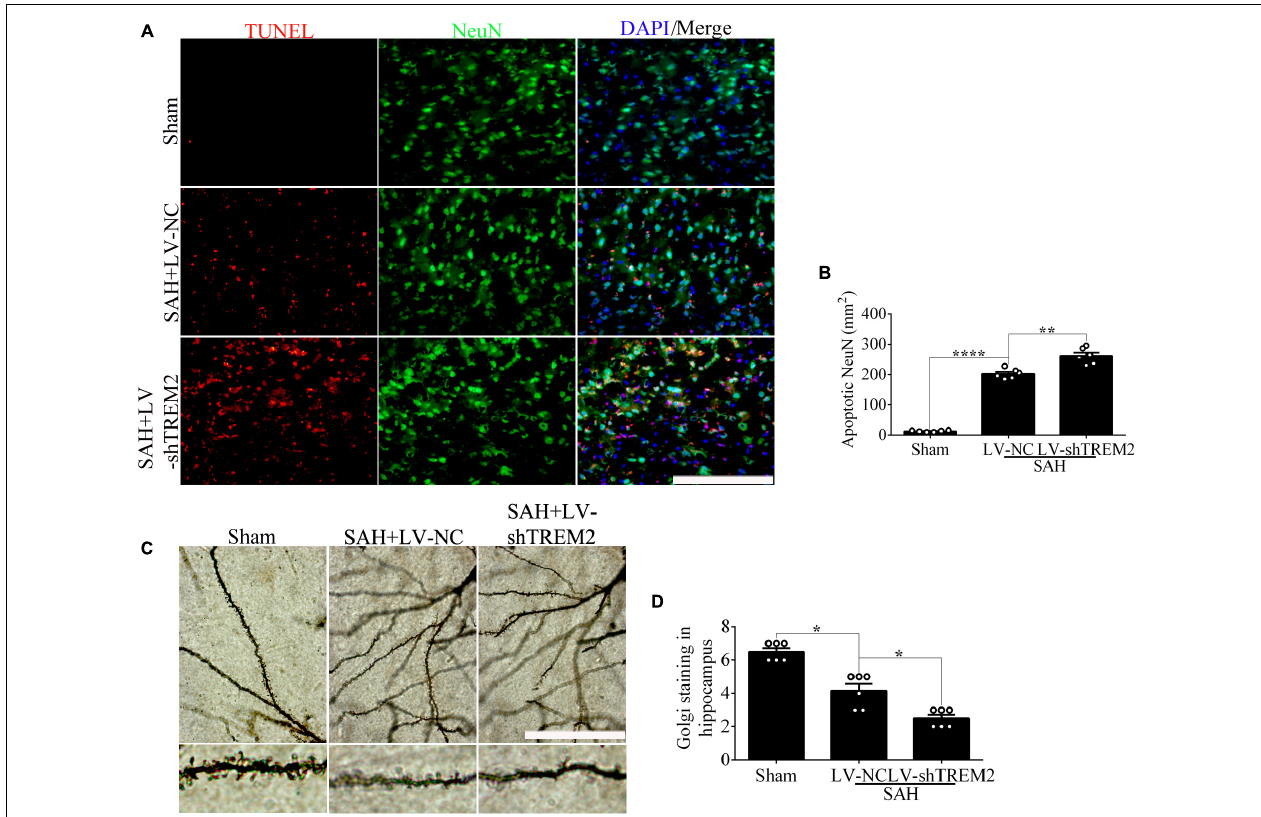
FIGURE 7 | Microglial triggering receptor expressed on myeloid cells 2 ( TREM2 ) silencing causes an aggravated neuronal injury at 3 days in vivo after subarachnoid hemorrhage (SAH). (A,B) Terminal deoxynucleotidyl transferase-mediated dUTP nick end-labeling (TUNEL) staining and apoptotic percentages of the neurons. (C,D) Golgi staining and quantitative analysis of axons. These data are shown as mean ± SEM ( *p < 0.05, ** p < 0.01, **** p < 0.001; A , scale bar = 25 µ m; C , scale bar = 10 µ m).